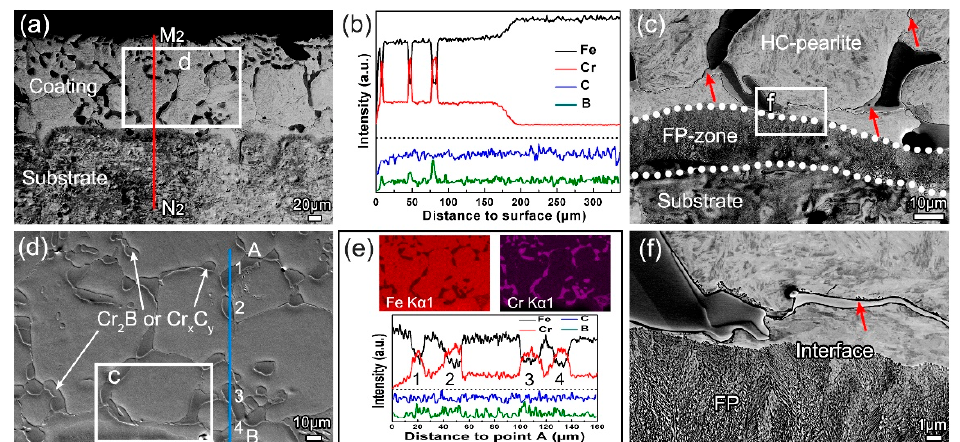
Figure 5. SEI and BSEI images showing the sectional microstructure and elemental distribution of BCr-60 sample: ( a ) sectional view of the coating; ( b ) EDS line scanning in ( a ) (M 2 to N 2 ); ( c ) ( d ) ( f )high magnification images corresponding to the white boxes; ( e ) EDS area scanning and line scanning corresponding to the region in ( d ).